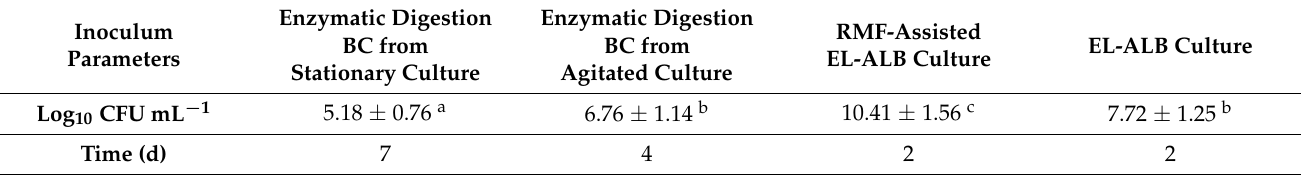
Table 1. Comparison of inoculum preparation